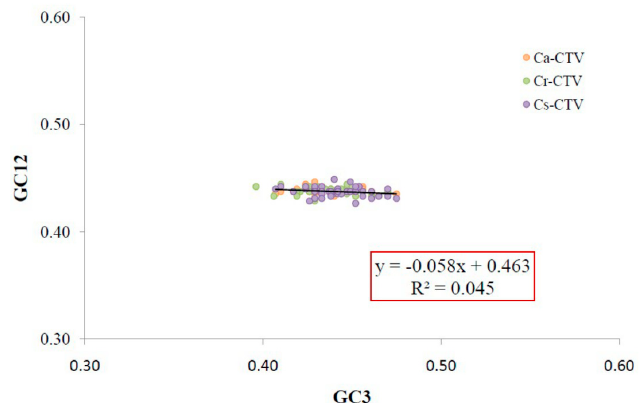
Figure 2. Neutrality plot analysis (GC12 vs. GC3) for the coat protein genes of CTV isolates. GC12 stands for the average value of GC contents at the first and second positions of the codons (GC1 and GC2), while GC3 refers to the GC contents at the thirdposition of the codons. The black line is the linear regression of GC12 against GC3; the regression curve can be described as y = − 0.058 x + 0.463, R 2 = 0.045. Different CTV subgroups are indicated with different color markers as shown to the right of the